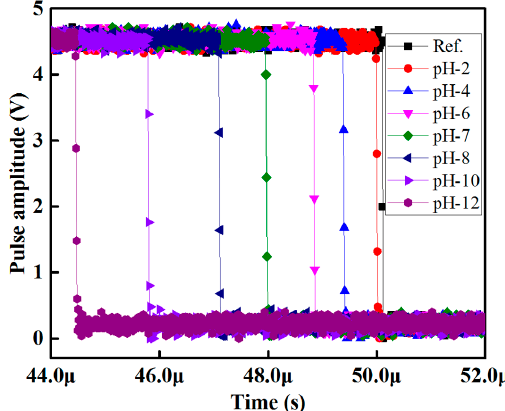
Figure 6. Pulse width response of the proposed optical-fiber PWM pH sensor array for methyl red containing sensing element S1.